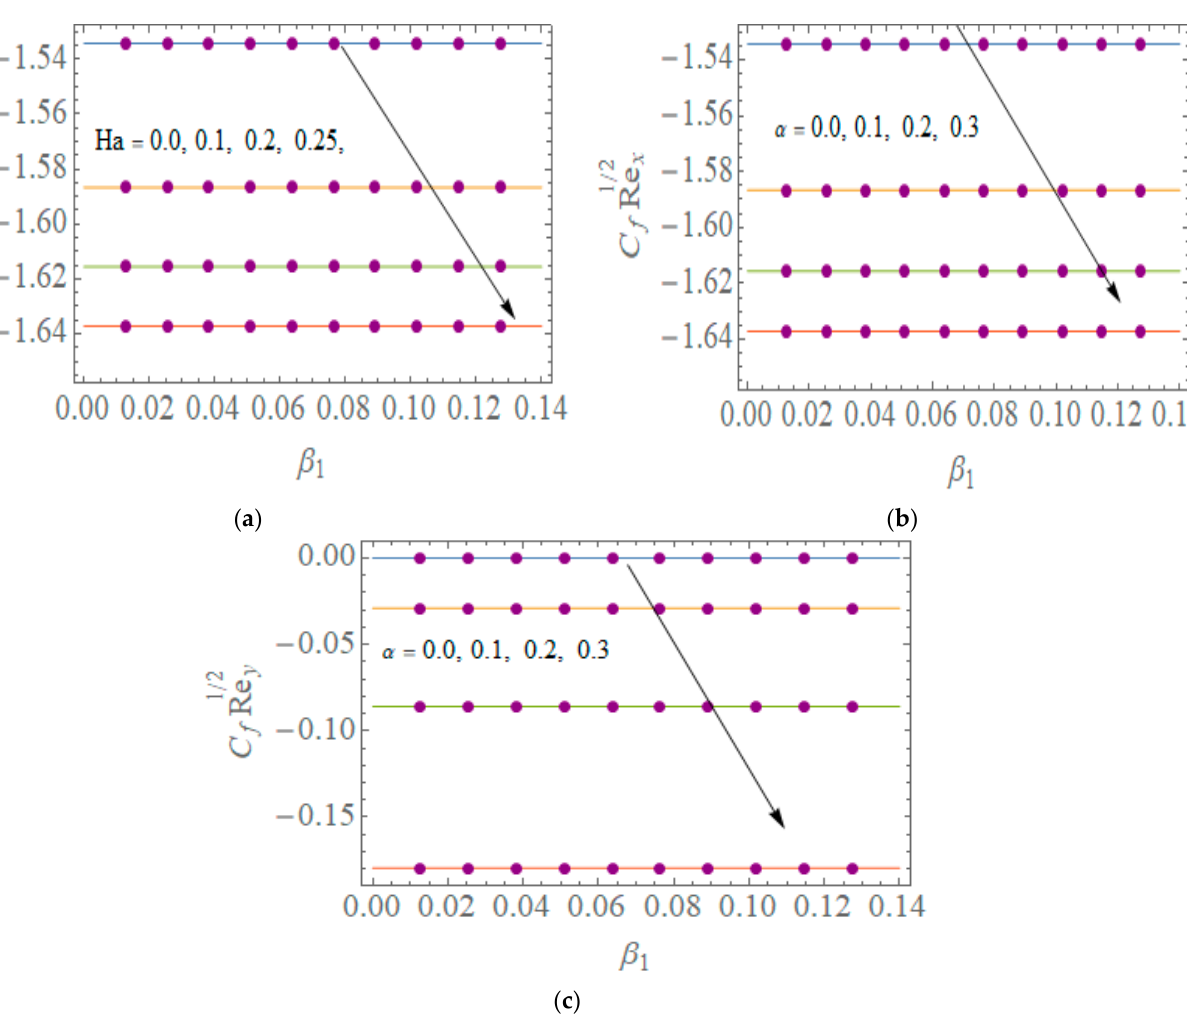
Figure 13. Assessment of TLM-BANN for f with reference dataset of TD-PNFM. ( a ) Variation of Ha for C f Re 1/2 x ; ( b ) Variation of α for C f Re 1/2 x ; ( c ) Variation of α for C f Re 1/2 y .